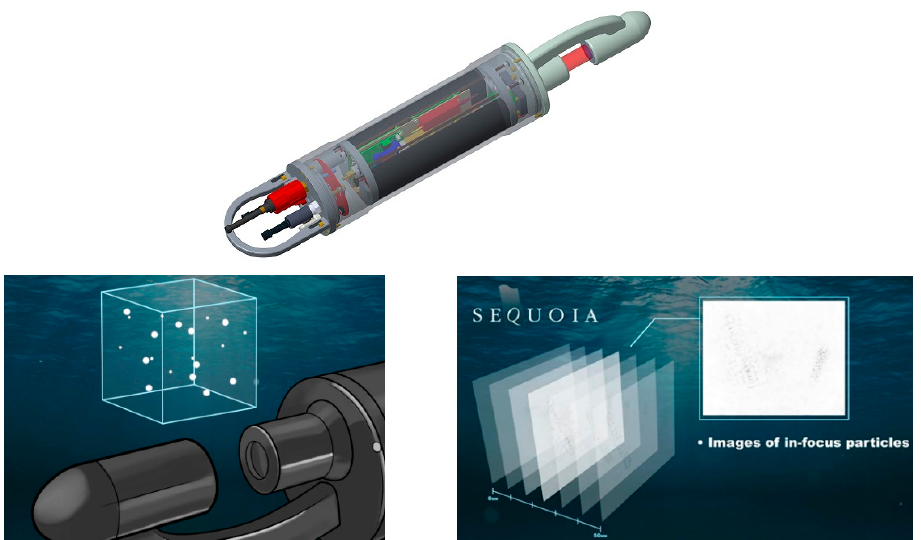
Figure 4. LISST-HOLO2 measurement principle.